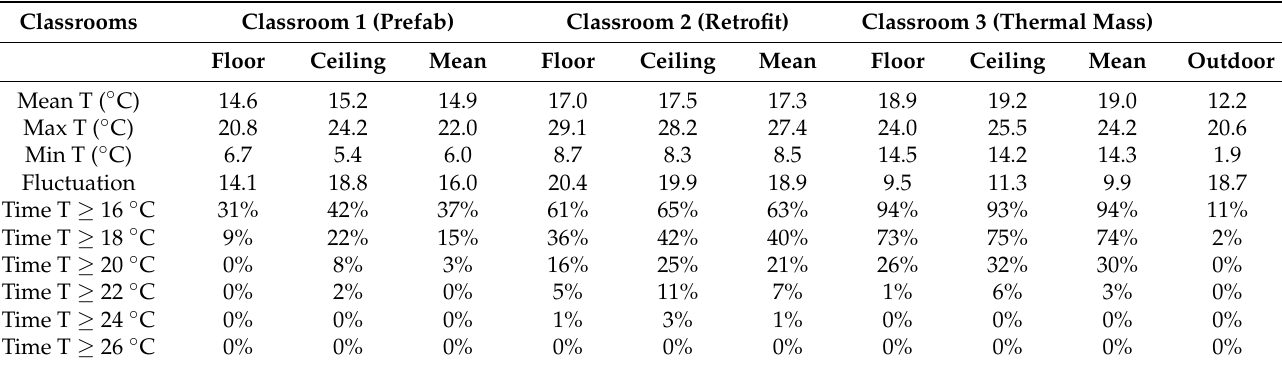
Table 2. Indoor temperatures and percentages of time related to different temperature ranges throughout winter (24 h per